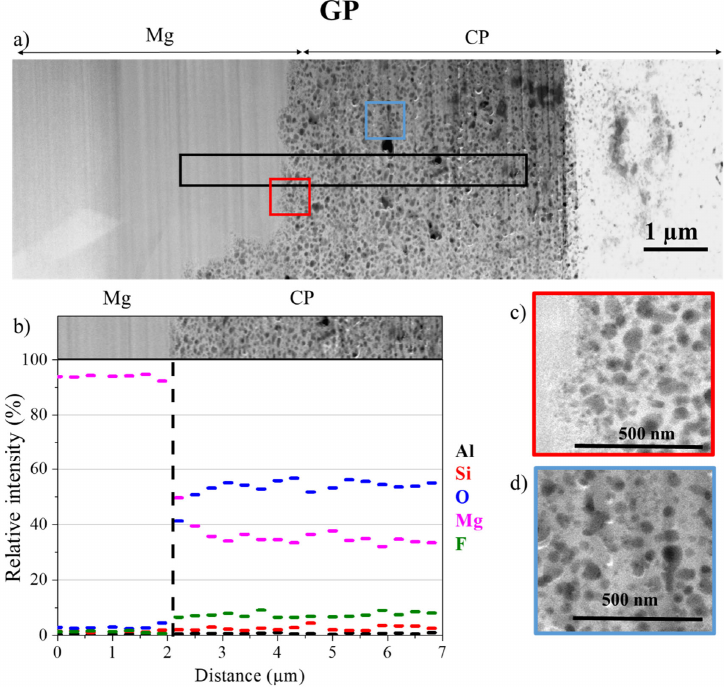
Figure 6. ( a ) Low magnification of HAADF-STEM images assembly of the interface between CP, MgZr for GP thin foil, ( b ) spatial distributions of elements obtained from EDX analysis (black rectangle in ( a )), zooms of the square areas enclosed in ( c ) red and ( d ) blue in ( a ). The difference in STEM contrast in the CP layer is due to a difference of thin foil thickness. For the GP sample (Figure 6), the analyzed area of the CP layer is homogenous, porous, and mainly consists of Mg and O with few amounts of F and Si (Figure 5b). The presence of these elements may attests of the formation of Mg(OH) 2 − x F x (x << 1). The Brucite partially substituted by F may present a semi ‐ crystalline structure as characterized by Raman microspectroscopy and GI ‐ XRD. For the GP ‐ NaF sample, the thickness of the CP layer measured from the STEM image of 6.4 μ m (Figure 7a) is about the same order of magnitude than the one obtained from SEM image analysis. The CP layer presents several zones highlighted in Figure 7b.